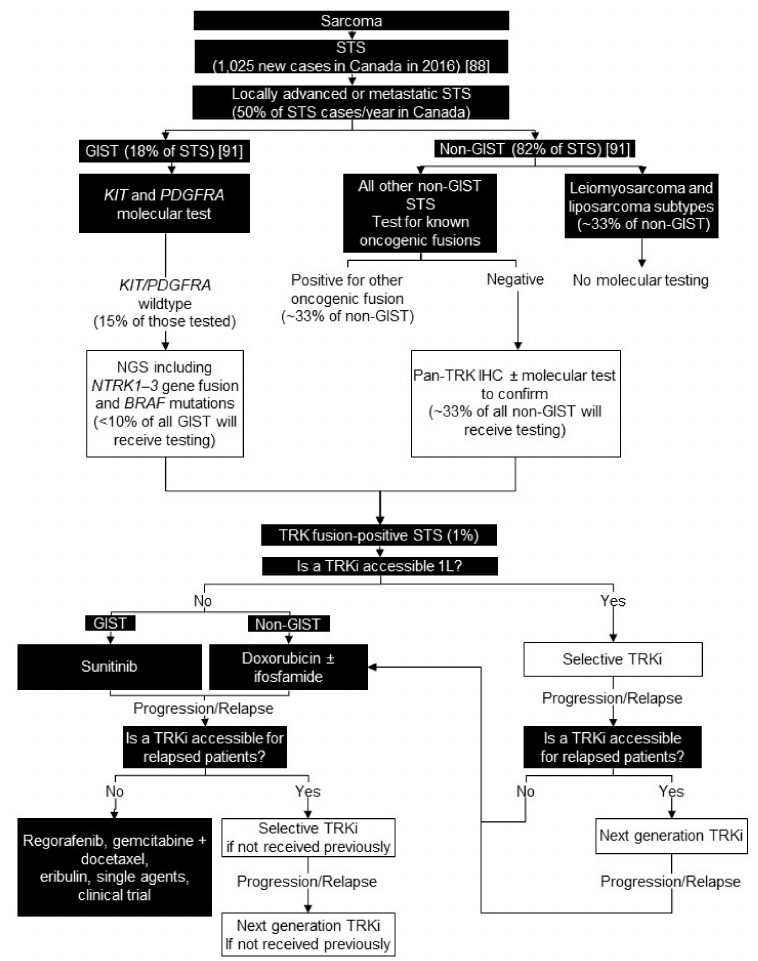
Figure4. Biomarkertestingandtreatmentforneurotrophictyrosinereceptorkinase( NTRK) genefusions in sarcoma. White boxes with black outlines represent either NTRK gene fusion testing or treatment with a TRKi. Black boxes with white text indicate all other steps that do not include either NTRK gene fusion testing or treatment with a TRKi. BRAF = B-Raf proto-oncogene, serine / threonine kinase; GIST = gastrointestinal stromal tumour; IHC = immunohistochemistry; KIT = KIT proto-oncogene, receptor tyrosine kinase; L = line; NGS = next generation sequencing; PDGFRA = platelet derived growth factor receptor alpha; STS = soft tissue sarcoma; TRK = tyrosine receptor kinase; TRKi = TRK inhibitor. Ducimeti è re et al. 2011 [88]; Canadian Cancer Society